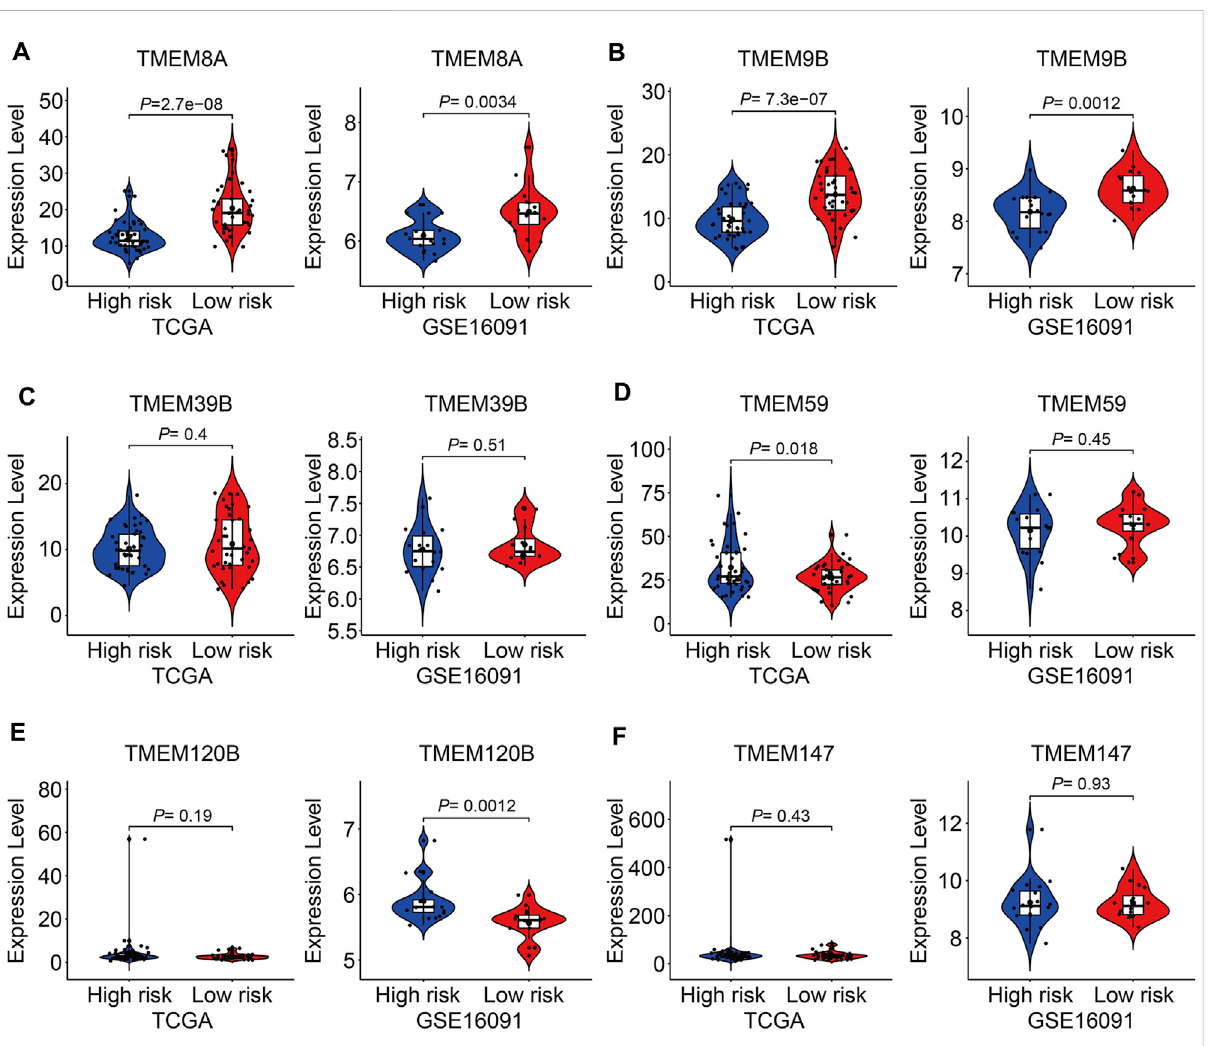
FIGURE 10 Expression of TMEM8A (A) , TMEM9B (B) , TMEM39B (C) , TMEM59 (D) , TMEM120B (E) , and TMEM147 (F) in high and low-risk